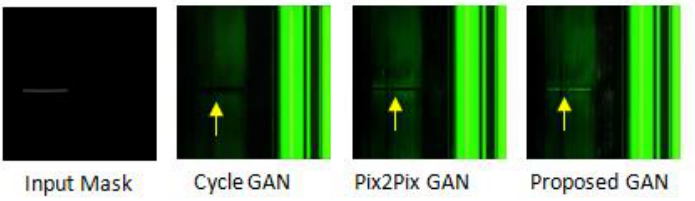
Figure 6. Comparison between the Magna-Defect-GAN and different image translation approaches.